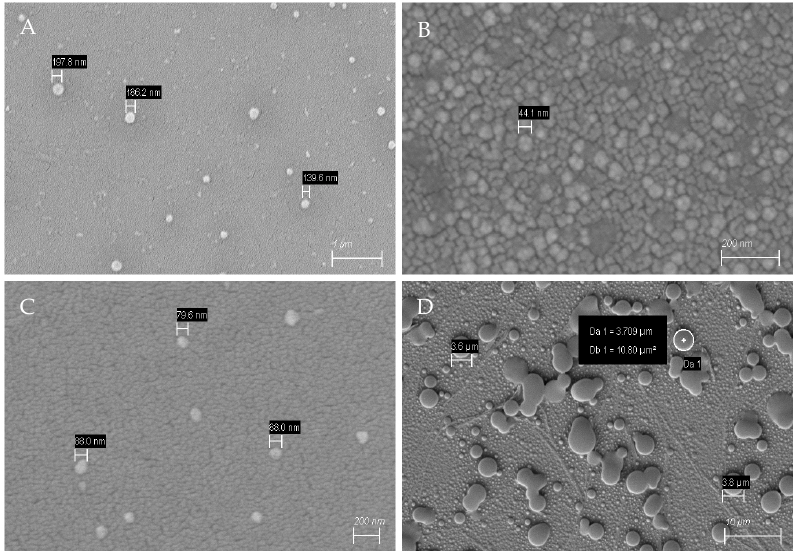
Figure 3. SEM of MIP and NIP nanoparticles revealing spherical shape. Their diameters are different; ( A – C ) are MIP nanoparticles resulting from protocol 1, 2, and 3, respectively. They are around 70–200 nm in diameter. Non-imprinted nanoparticles ( D ) are around 3.6–3.8 µm in diameter.